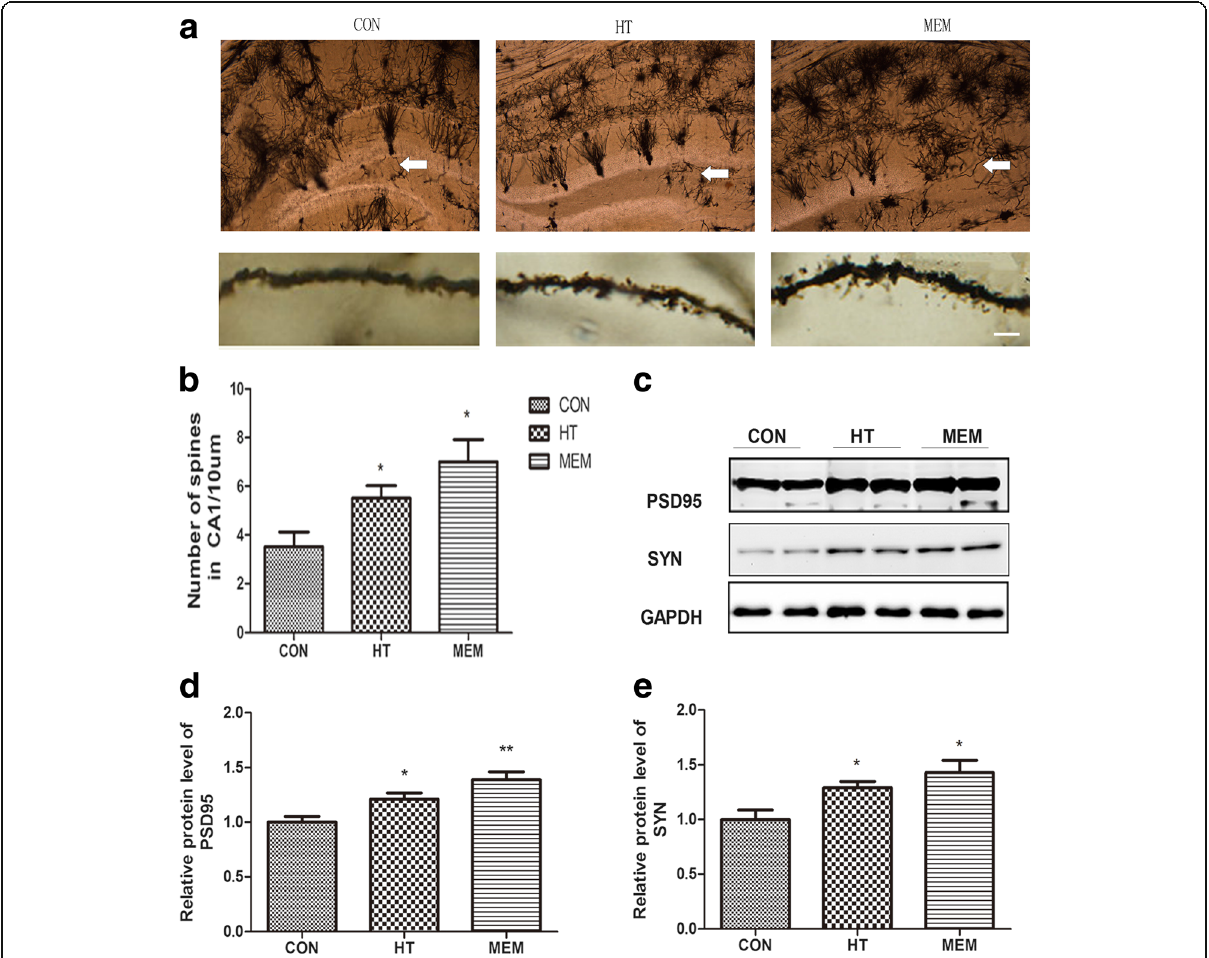
Fig. 5 HT improves synaptic function in APP/PS1 Transgenic Mice. a Golgi staining of the hippocampal area(top), HT mediated preservation of the number of spines per given dendritic length in the hippocampus CA1. Scale bar = 10 μ m. b Quantitative analysis of spine density in CA1. c The PSD95 and SYN protein levels were measured by Western blotting in the different groups. d Quantitative analysis of PSD95 expression. * P < 0.05, ** P < 0.01 versus control group. e Quantitative analysis of SYN expression. * P < 0.05 versus control group, n = 6 per